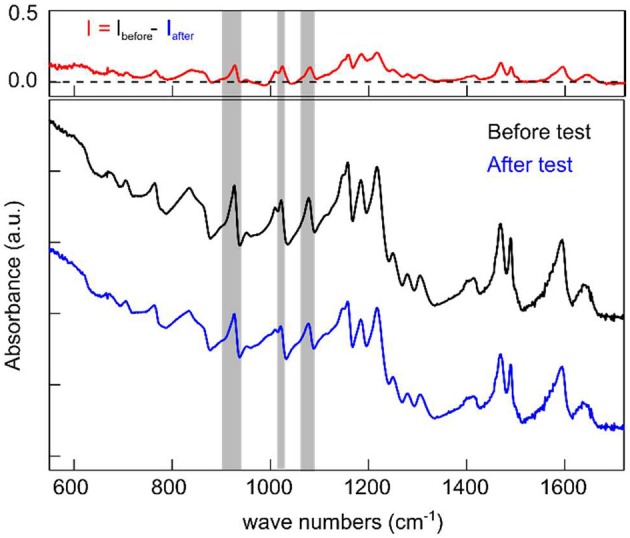
FTIR spectra of SPEEK/MWCNTs-OH membrane before (black) and after (blue) test; Top, difference spectrum Ibefore-Iafter.